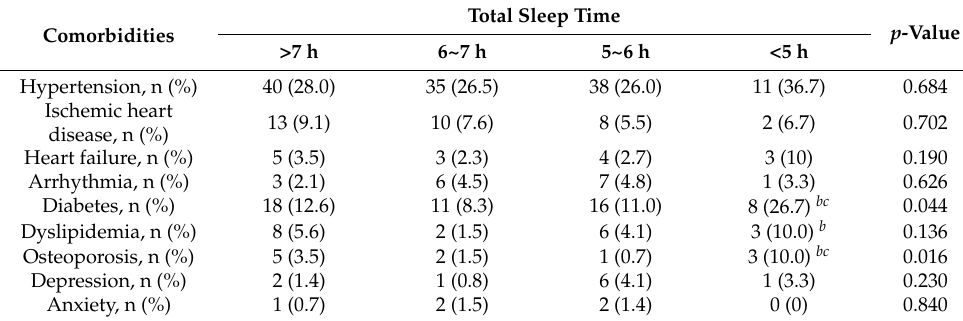
Table 3. Comorbidities from four groups according to total sleep time.